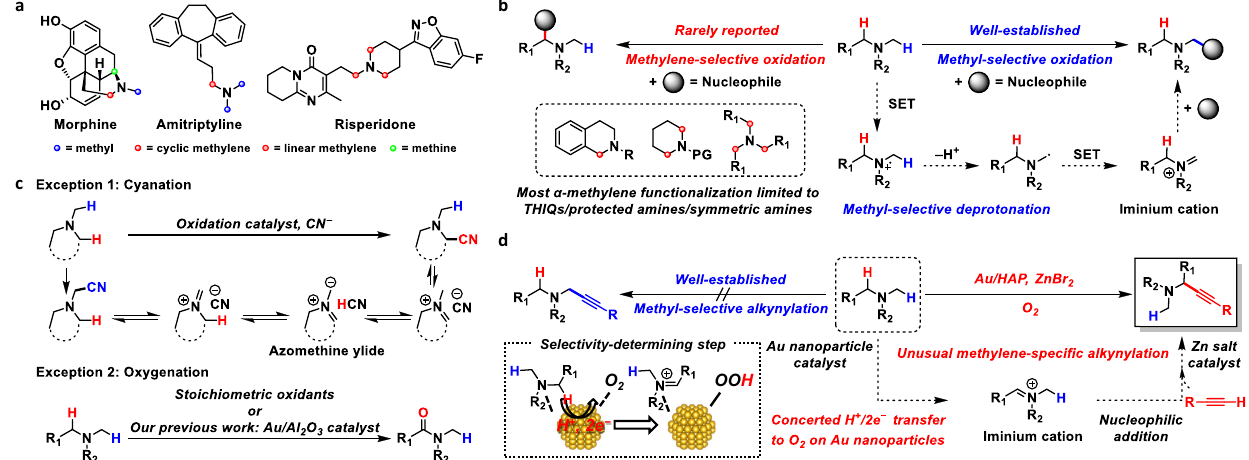
Fig. 1 | Overview of the oxidative α -C – H functionalisation of tertiary amines. a Representative drugs and natural products possessing tertiary amine structures. b Dif fi culty in controlling the regioselectivity of the oxidative α -C – H functionali- sation of tertiary amines. c Rare examples of oxidative α -C – H functionalisations showing exceptional regioselectivity to α -methylene C – H bond: cyanation and